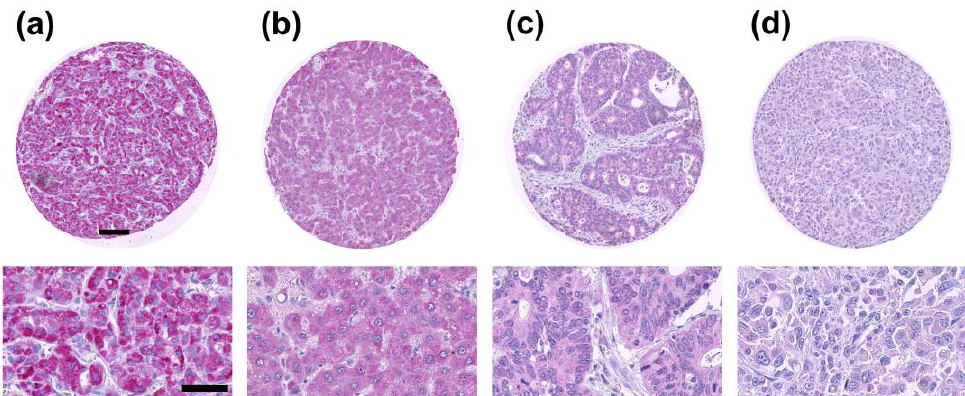
Figure 1. Representative images of thioredoxin interacting protein (TXNIP) immunostaining results on multi-tumor tissue micro array (TMA). ( a ) Strong TXNIP protein expression in an oncocytoma sample, ( b ) moderate TXNIP protein expression in a hepatocellular carcinoma sample, ( c ) weak TXNIP protein expression in a mucinous ovarian cancer sample, ( d ) negative TXNIP protein expression in an anaplastic thyroid cancer sample. Staining with Permanent Red. Scale bar (upper panel) = 100 µ m, scale bar (lower panel) = 50 µ m.